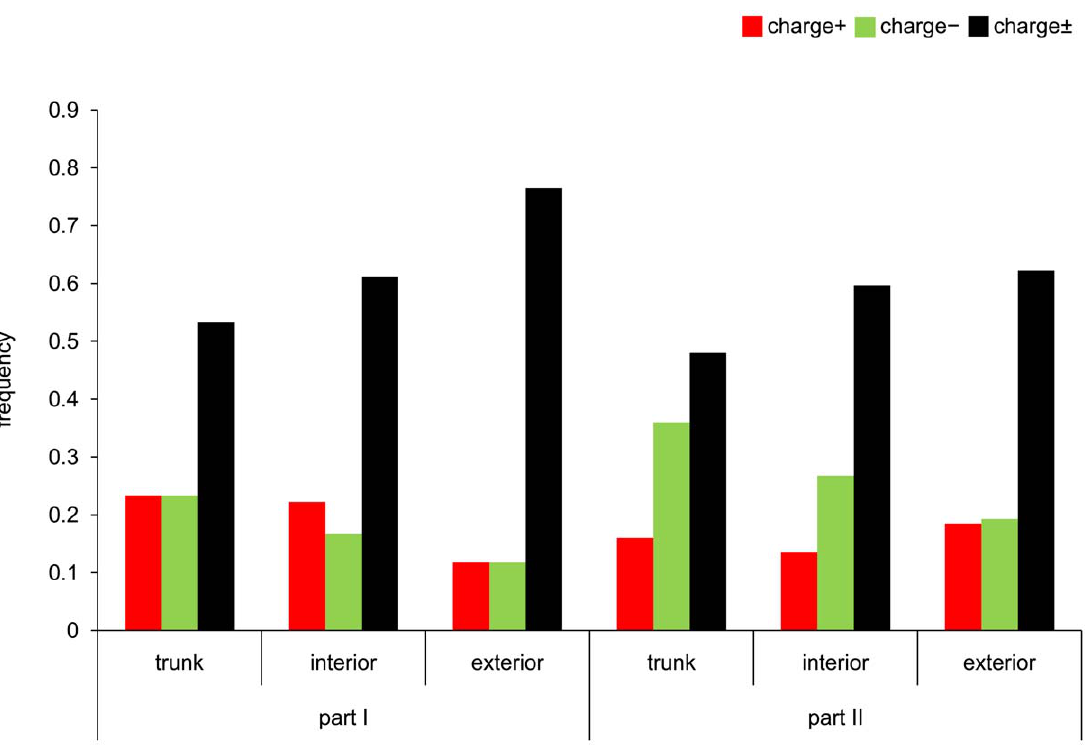
Figure 6. Substitution patterns before and after the introduction of oseltamivir in HA1 of A/H3N2 virus. After dividing the phylogenetic tree of A/H3N2 virus into part I and II, which roughly corresponded to the period before and after the introduction of oseltamivir in humans, respectively, the proportions of charge + (red bar), charge 2 (green bar), and charge 6 (black bar) substitutions in HA1 on the NGS 6 branches were obtained for part I and II separately. The numbers of amino acid substitutions on the NGS 6 branches in part I and II are shown in Table S2.